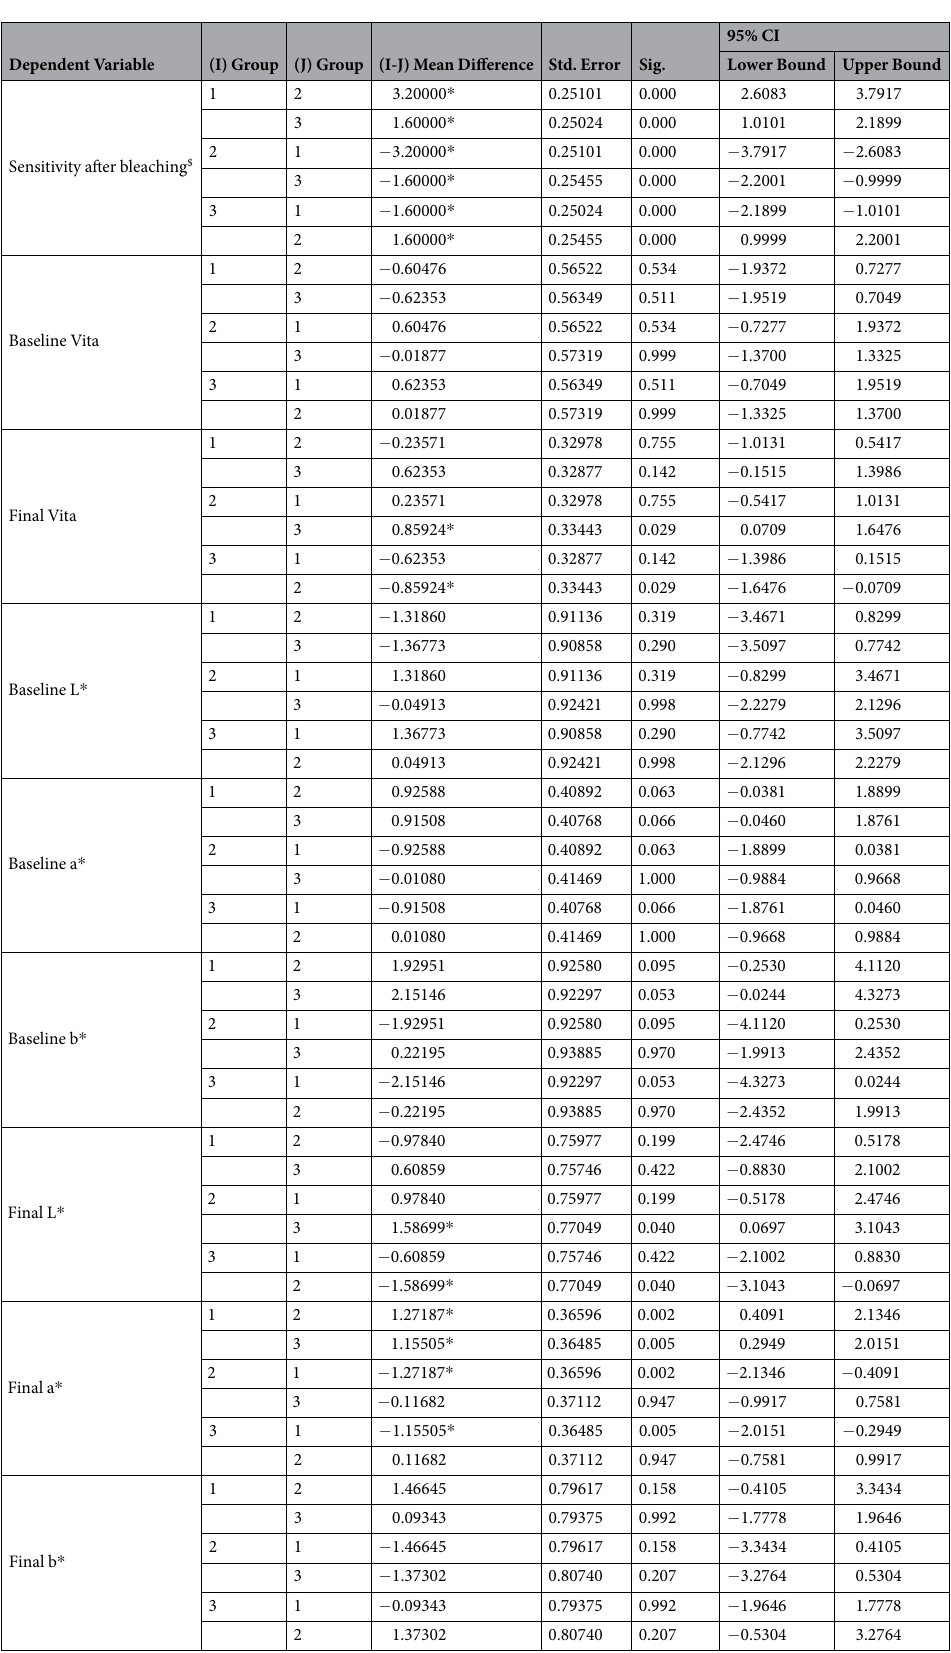
Table 4. Post-hoc test of tooth sensitivity and shade value variations between groups before and after bleaching. Group 1 = Teeth bleached with ozone then 38% hydrogen peroxide (n = 90 tooth surfaces in 15